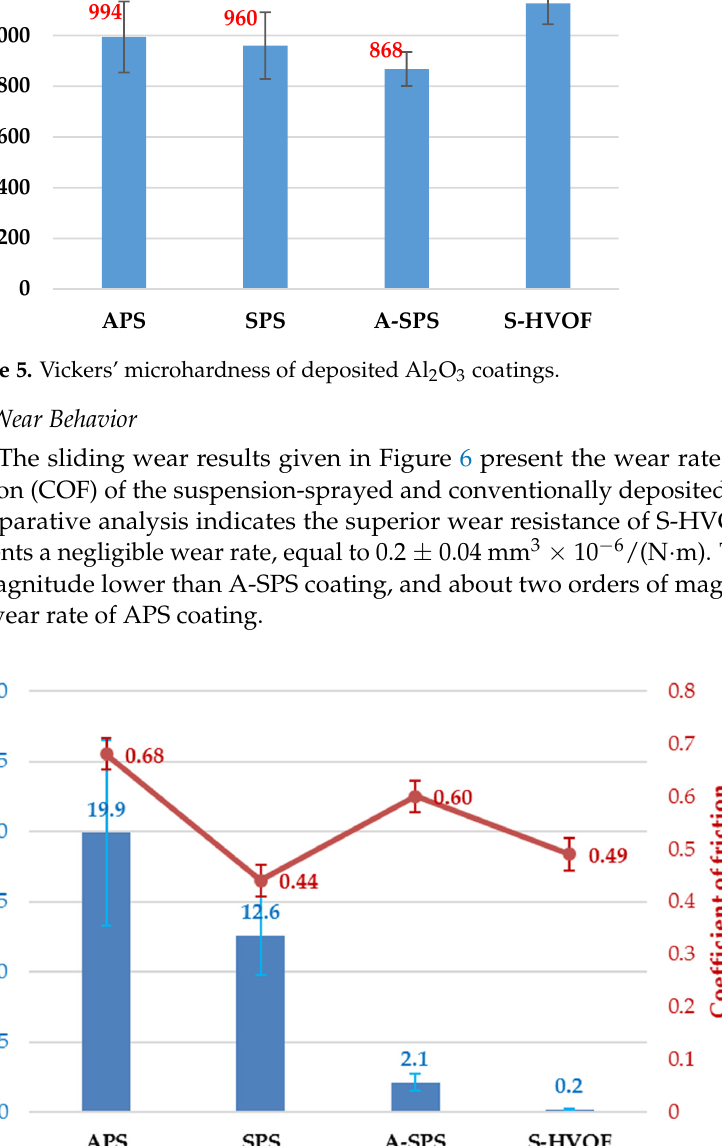
Figure 6. Wear rate and friction coefficient of different techniques for sprayed alumina coatings.